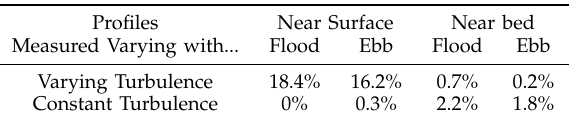
TABLE IV C OMPARISON OF DEL FROM VARYING MEASURED PROFILES TO THE DEL FROM APPLYING CONSTANT TURBULENCE WITH MEAN PREDICTED SHEAR